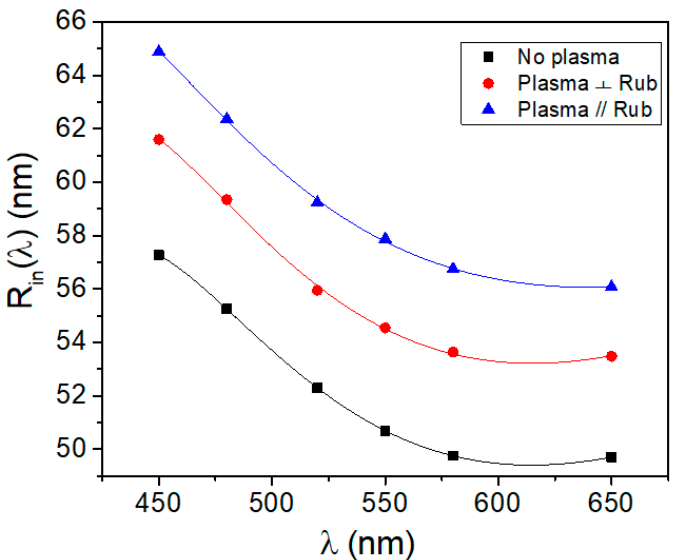
Figure 4. In-plane retardation R in of the UV-polymerized HCM009 samples with different surface treatment conditions vs. light wavelengths.